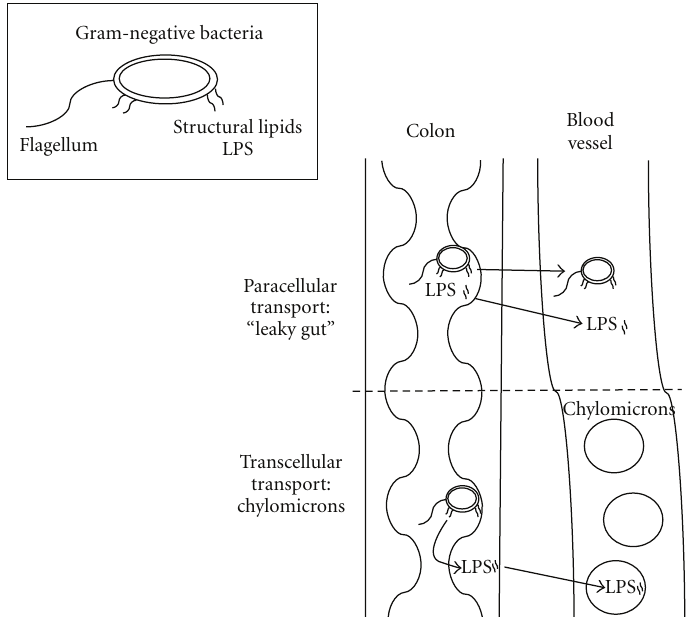
Figure 3: Diagram of the two primary methods of LPS entry into circulation: paracellular and transcellular. In paracellular transport or “leaky gut” either the entire bacteria or bacterial components such as LPS enter the circulation. In transcellular transport, chylomicrons take up LPS in